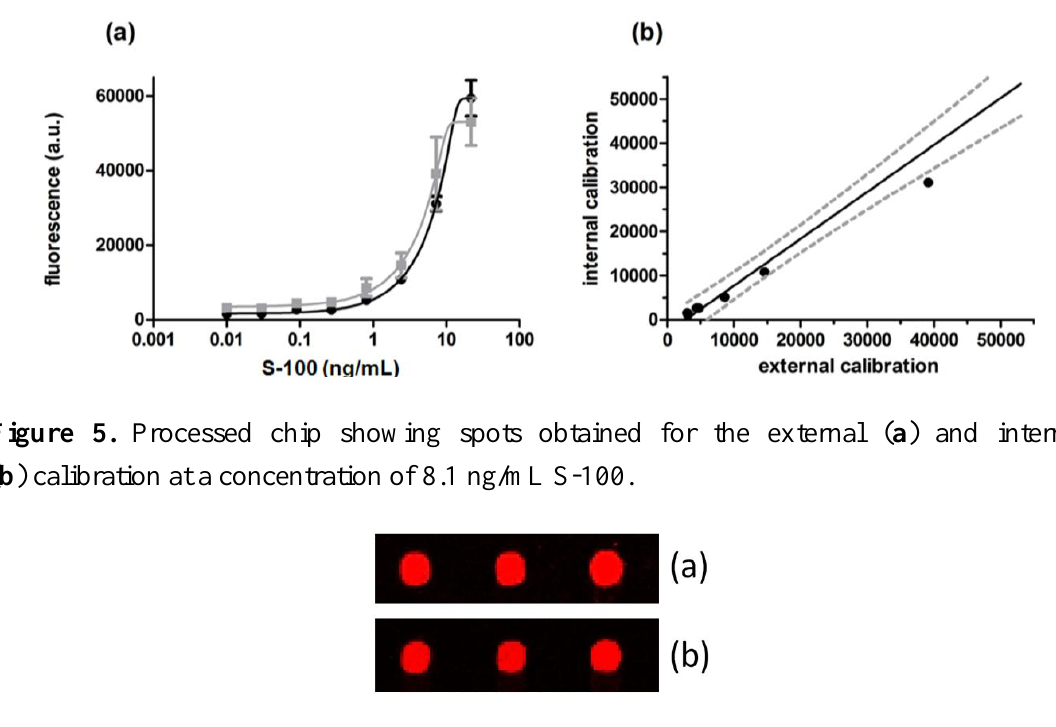
Figure 4. Calibration curves ( a ) and Scatter plot ( b ) for the internal ( ) and external chip calibration ( ). Internal and external calibration curves cover a very similar measurement range and most fluorescence intensity values cluster within the 95% confidence band (grey dotted lines) of the fit line. The coefficient of determination (R 2 ) was 0.968.